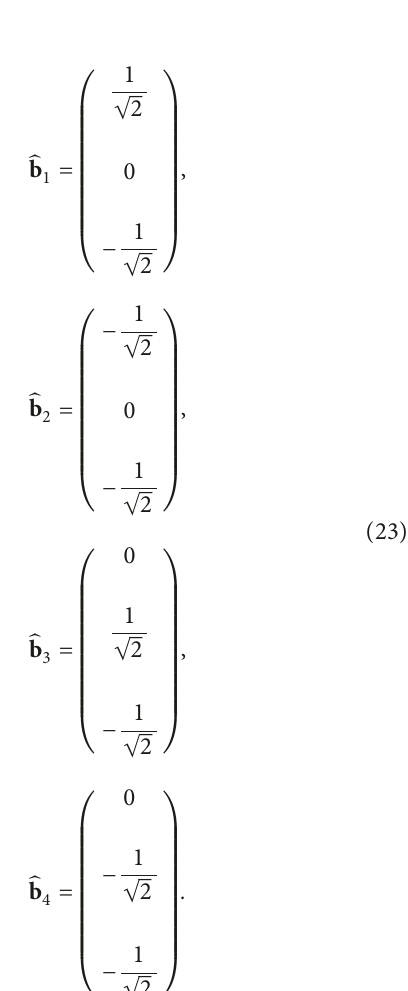
Figure 3: Bond orientation of fcc crystal structures: (a) (001), (b) (110), and (c)